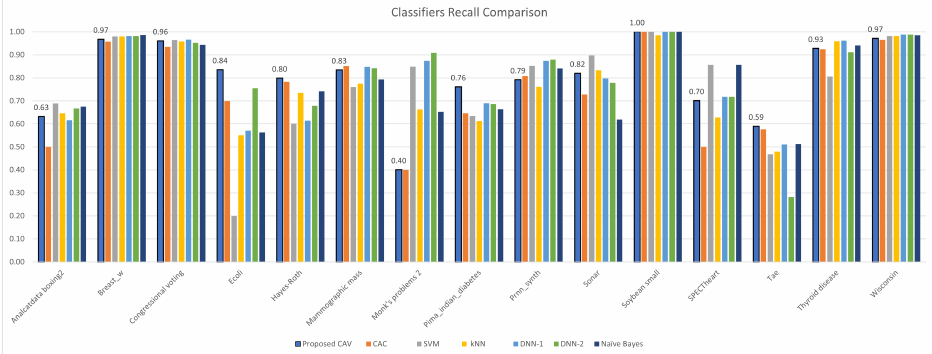
Figure 10. CAV with other classifiers; recall comparison for the test datasets.